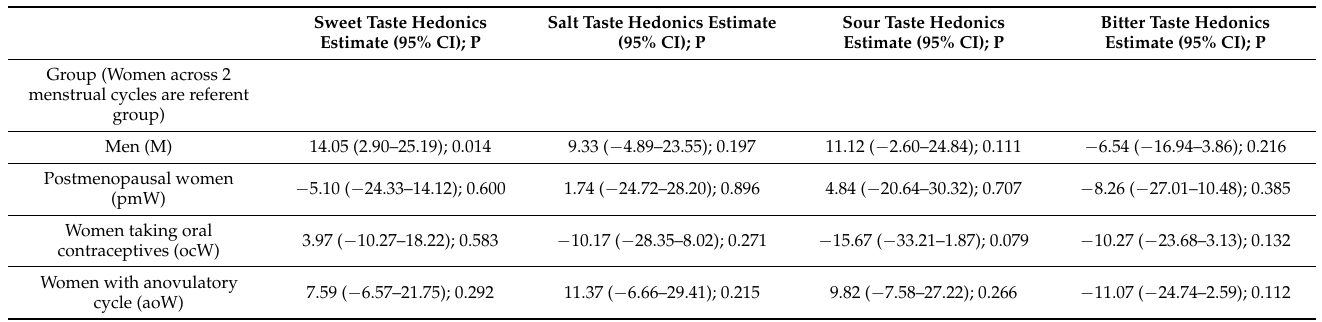
Table 6. Differences in gustatory hedonic perception across study groups and measurements or menstrual cycle phases, using linear mixed models controlled for age, smoking, and waist-to-height